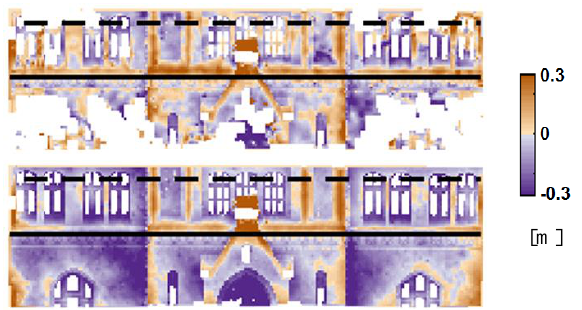
Figure 8. Deviations SURE-TLS (top) and deviations PS-TLS (bottom) of façade 1